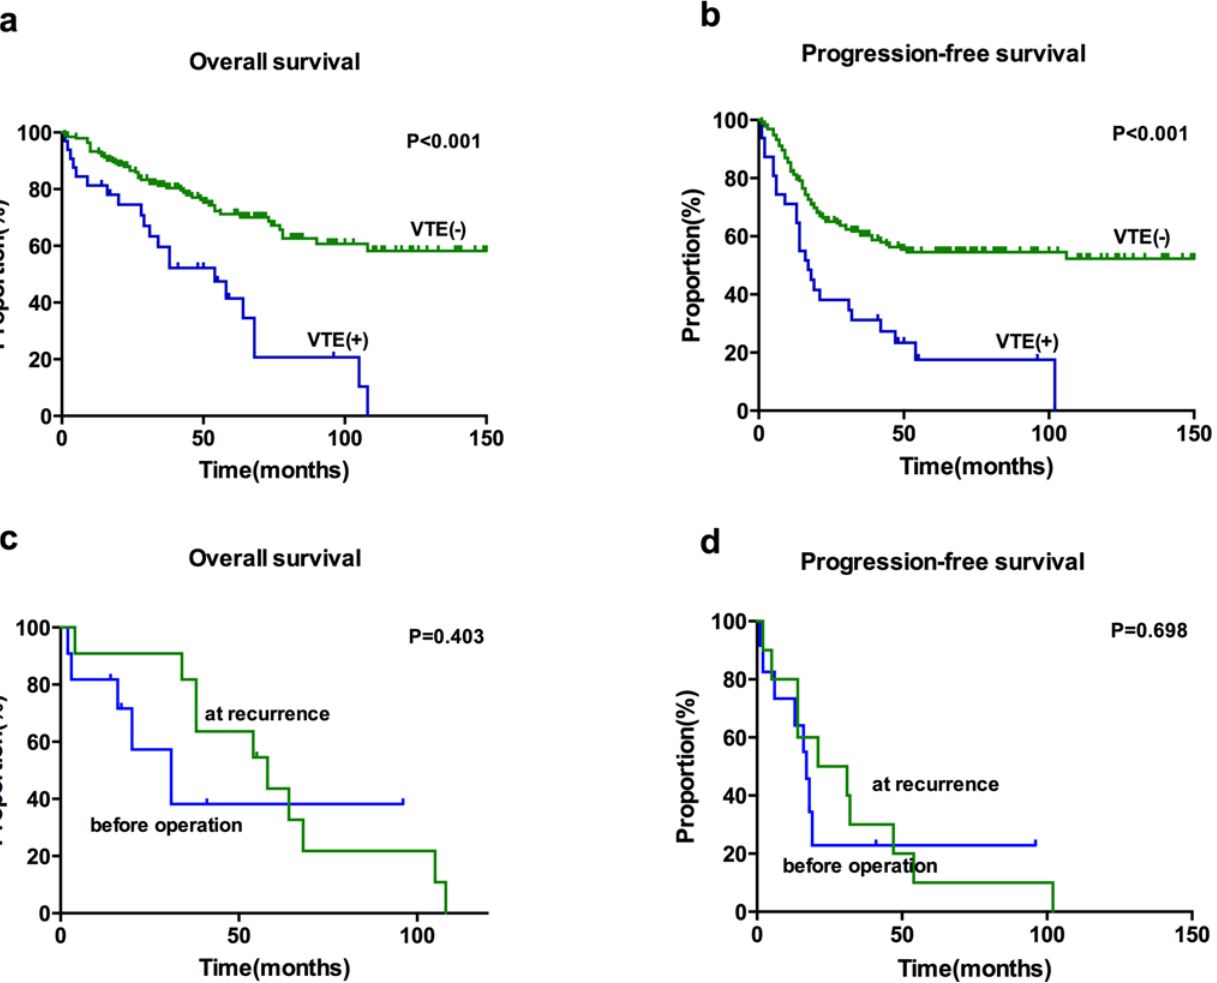
Fig 2. Kaplan-Meier survival curves of venous thromboembolism (VTE) in ovarian CCC. (a). Overall survival analyzed for cases with or without VTE. (b). Progression-free survival analyzed for cases with or without VTE. (c) Overall survival analysis based on timing of VTE. (d) Progression-free survival analysis based on the timing of the